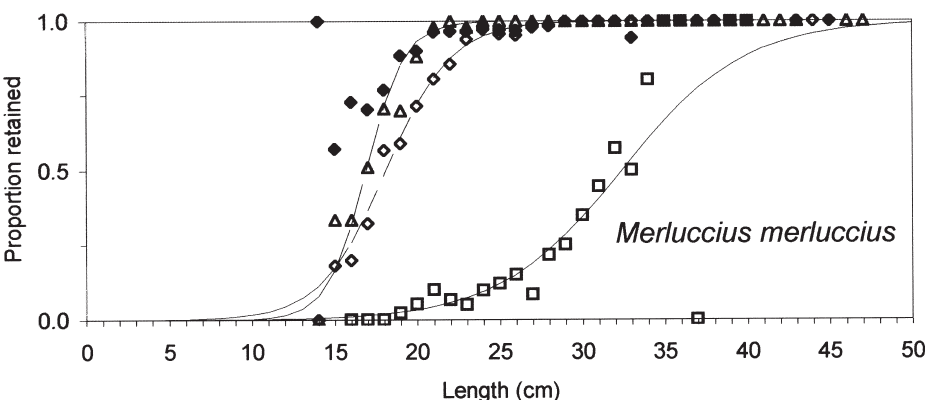
F IG . 6. – Selectivity curves for Merluccius merluccius (European hake) based on pooled data, together with observed retentions in the four cod ends. _ _ _ 70D; _ . _ . _ 80D; ____ 65S. Observed retention is expressed as black lozenges (65D), triangles (70D), white lozenges (80D) and squares (65S).